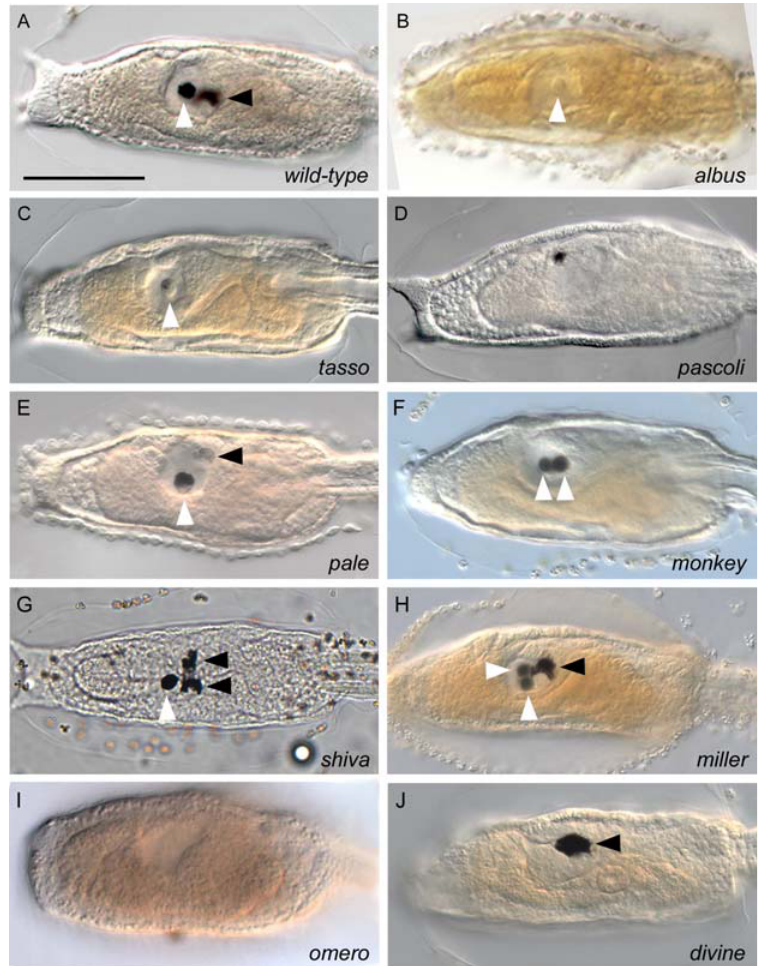
Figure 1. Homozygous mutant phenotypes with defects in the formation of sensory organs and brain vesicle. (A,B) Compared to wild- type larvae, no development of melanin is seen in the sensory organs of albus larvae. Scale bar, 100 m m. (C) Few pigment spots are observed in the otolith of tasso . (D) Only one undefined pigmented sensory organ is present in pascoli . (E) In pale , the ocellus is weakly pigmented, while the otolith is normal. (F) Supranumerary pigment cells in the otolith and none in the ocellus are observed in monkey . (G, H) Enlarged ocellus pigmentation and two otolith pigment cells occur in the shiva and miller mutants, respectively. (I) No pigmentation and at least no otolith are observed in omero . (J) The sensory vesicle of divine is not cavitated. White and black arrowheads indicate otolith and ocellus, respectively.